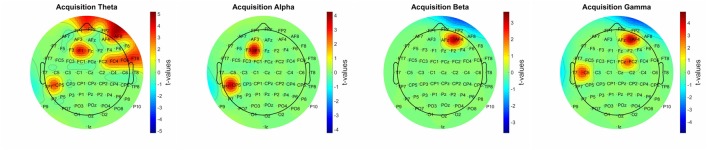
Significant power-performance correlation during acquisition in different frequency bands. The corrected t-values in different frequency bands were plotted to a topographical map using EEGLab “topoplot” function.